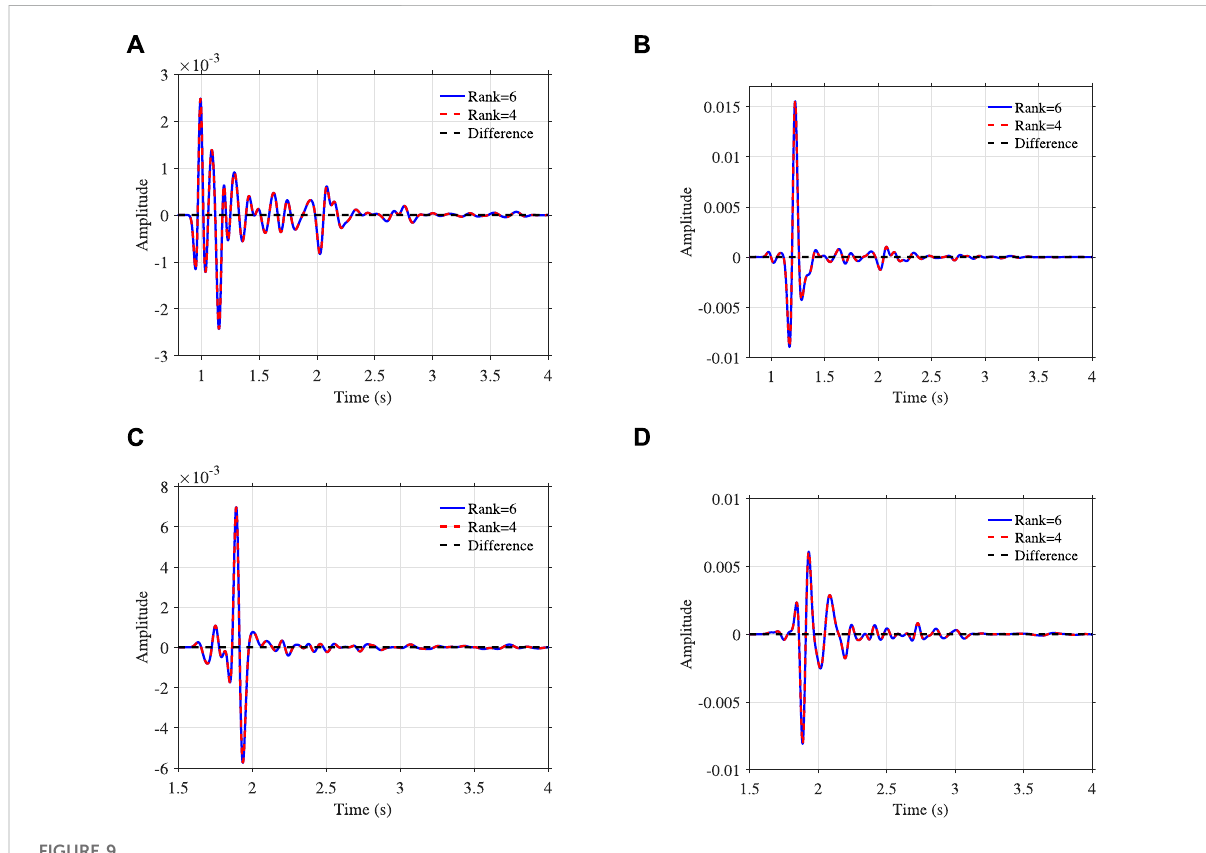
FIGURE 9 Observed seismic traces at ( x , z ) =(2375, 12.5) m (A,B) , at (6125, 12.5) m (C,D) . Panels (A,C) for v x and (B,D) for v z